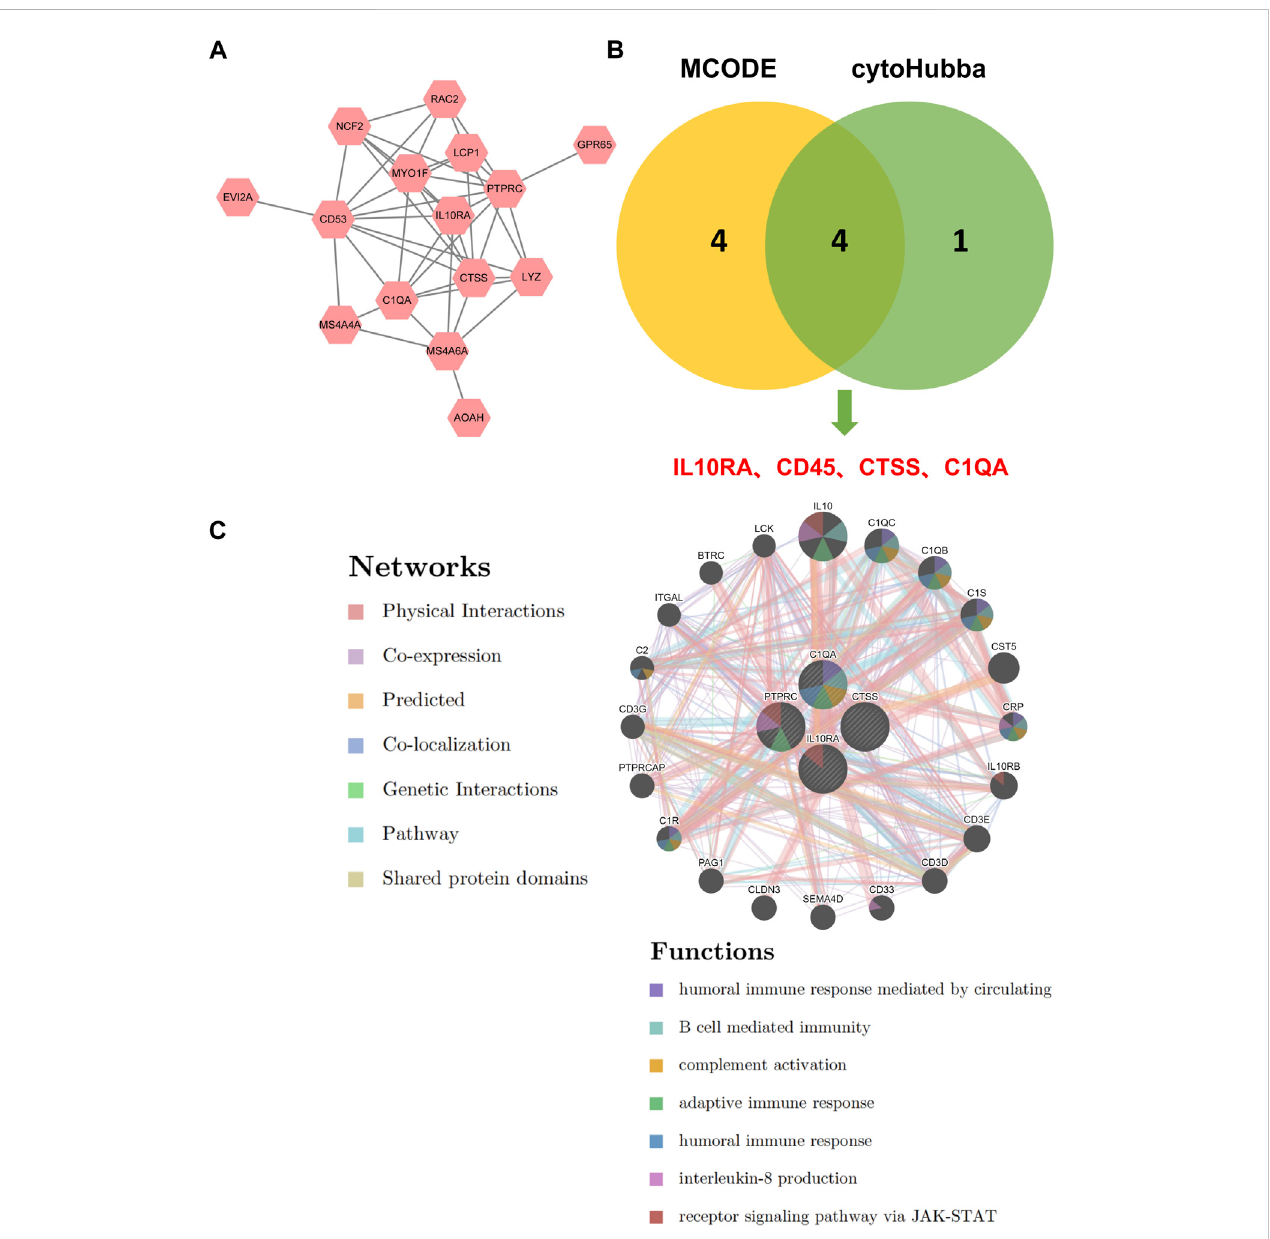
FIGURE 5 Identi fi cationofhubgenesforCKD. (A) PPInetworkofkeygenes. (B) TheintersectionofthekeygenescalculatedbyMCCandMCODEisvisualizedusing Venn diagram. (C) Hub genes and their co-expression genes were analyzed via